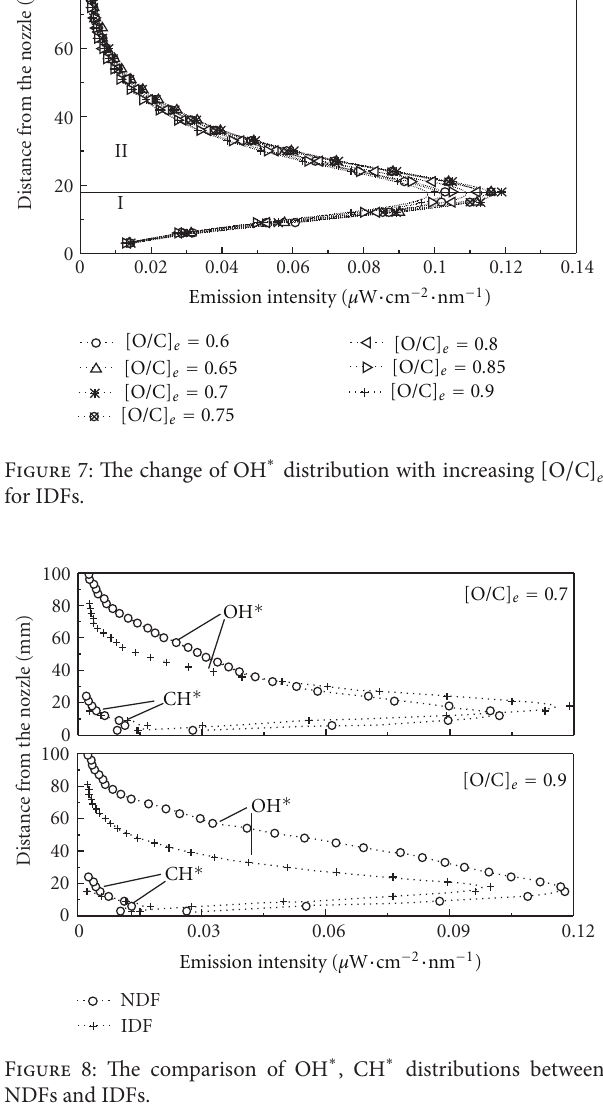
, CH distributions between ∗ ∗